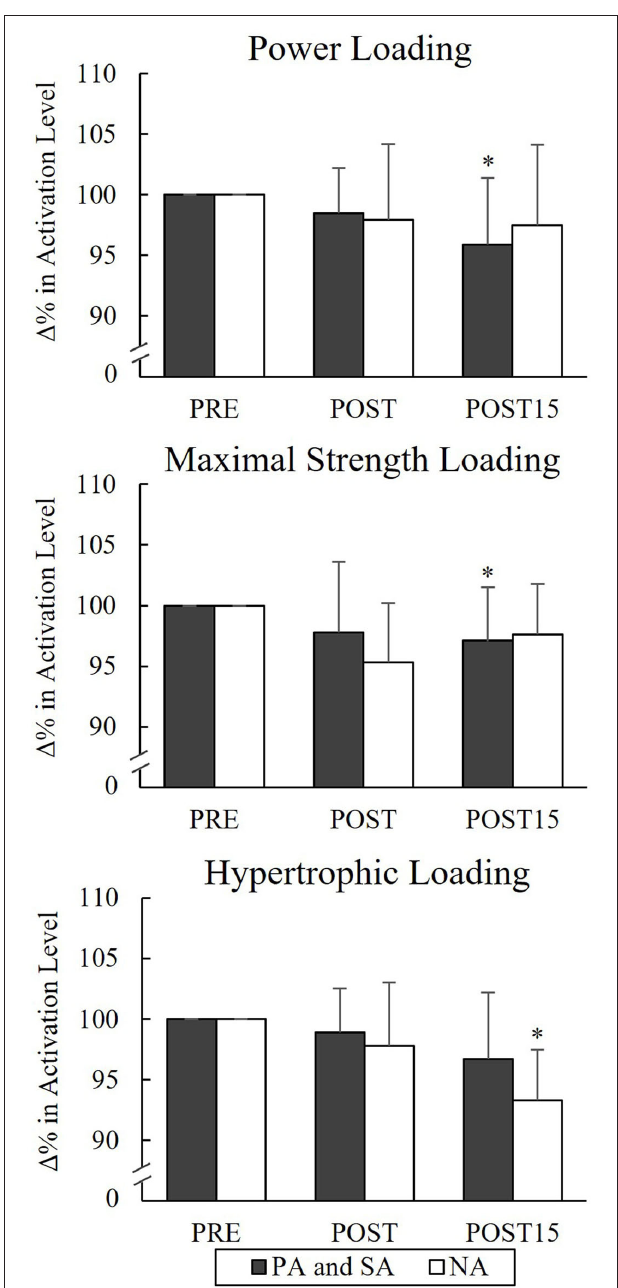
FIGURE 7 | Relative changes in maximal voluntary activation of quadriceps femoris muscle in the combined group of power (PA), strength (SA) athletes, and non-athletes (NA). * p < 0.05 refers to within-group significances compared to Pre.